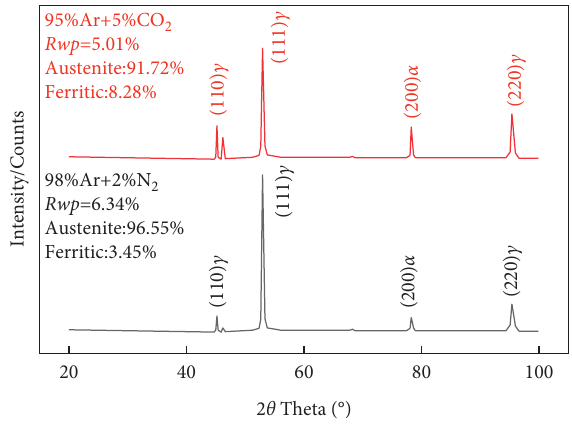
Figure 9: XRD results in